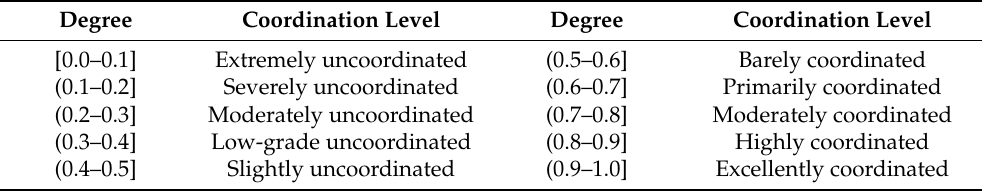
Table 2. Classification of coordination